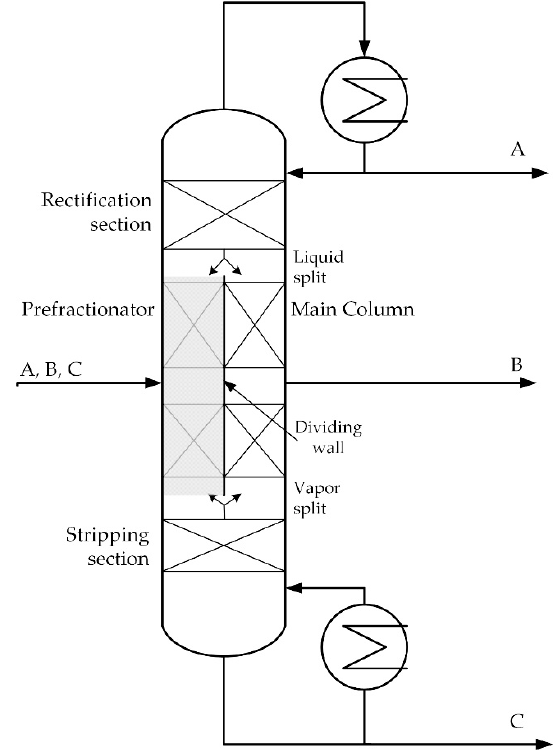
Figure 5. Schematic representation of a divided-wall column for the separation of a three-component mixture (according to [89]).